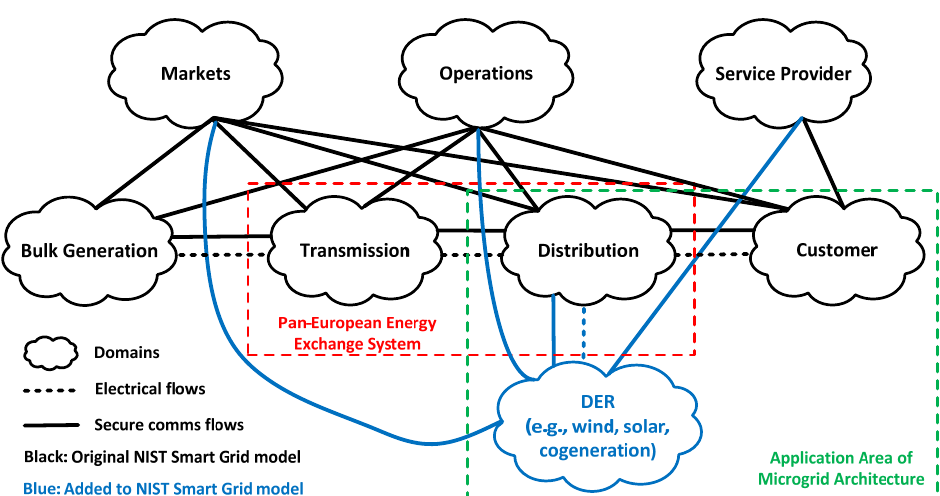
Figure 3. CEN/CENELEC/ETSI Smart Grid conceptual model.